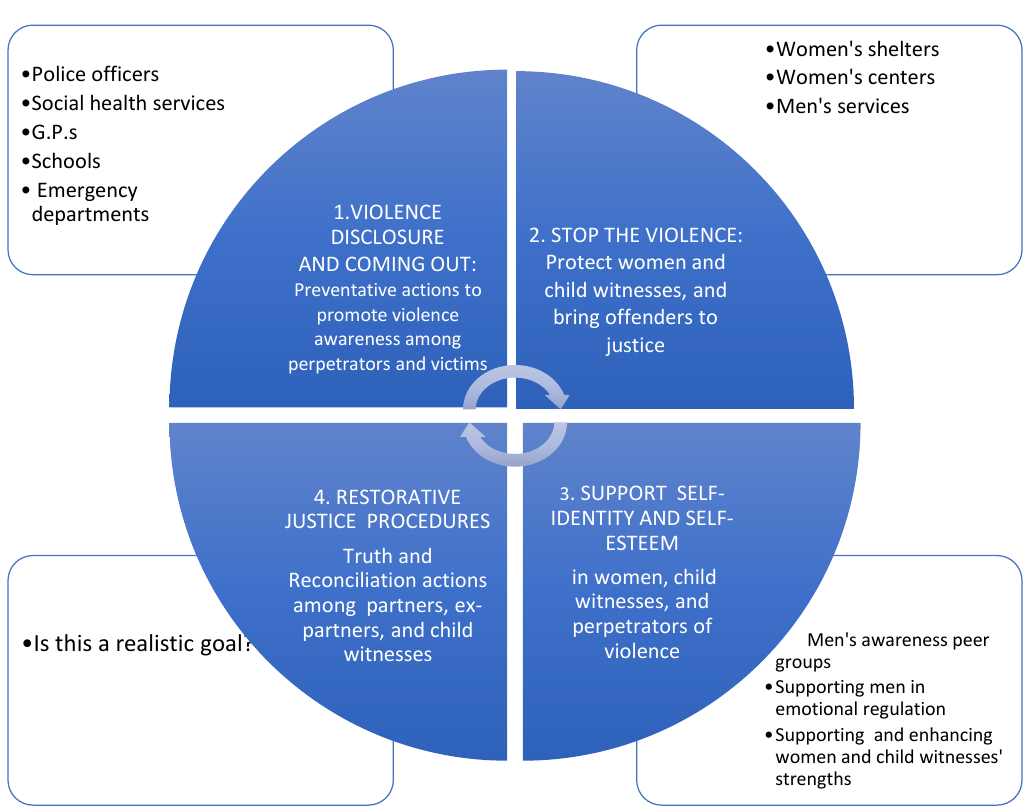
Figure 2. The ecological approach: goals, actions and actors at different levels in terms of their interdependence and within the model time frame.